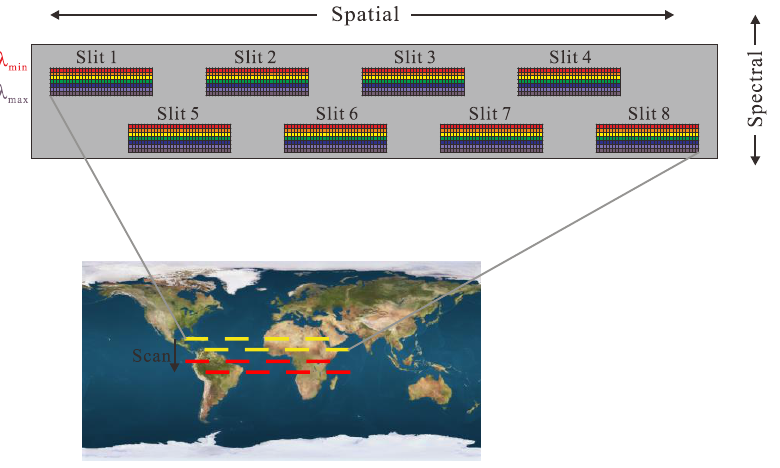
Figure 2. Instantaneous projection of a multi-slit LWIR imaging spectrometer (detector plane).